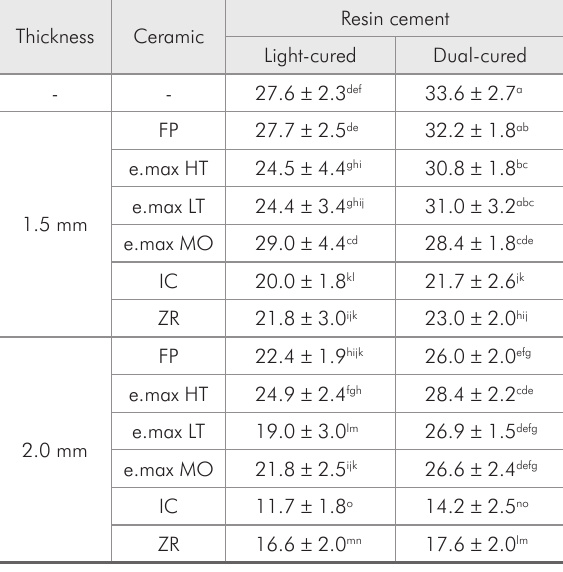
Table 3 - Means and standard deviations for the Knoop hardness number (KHN).